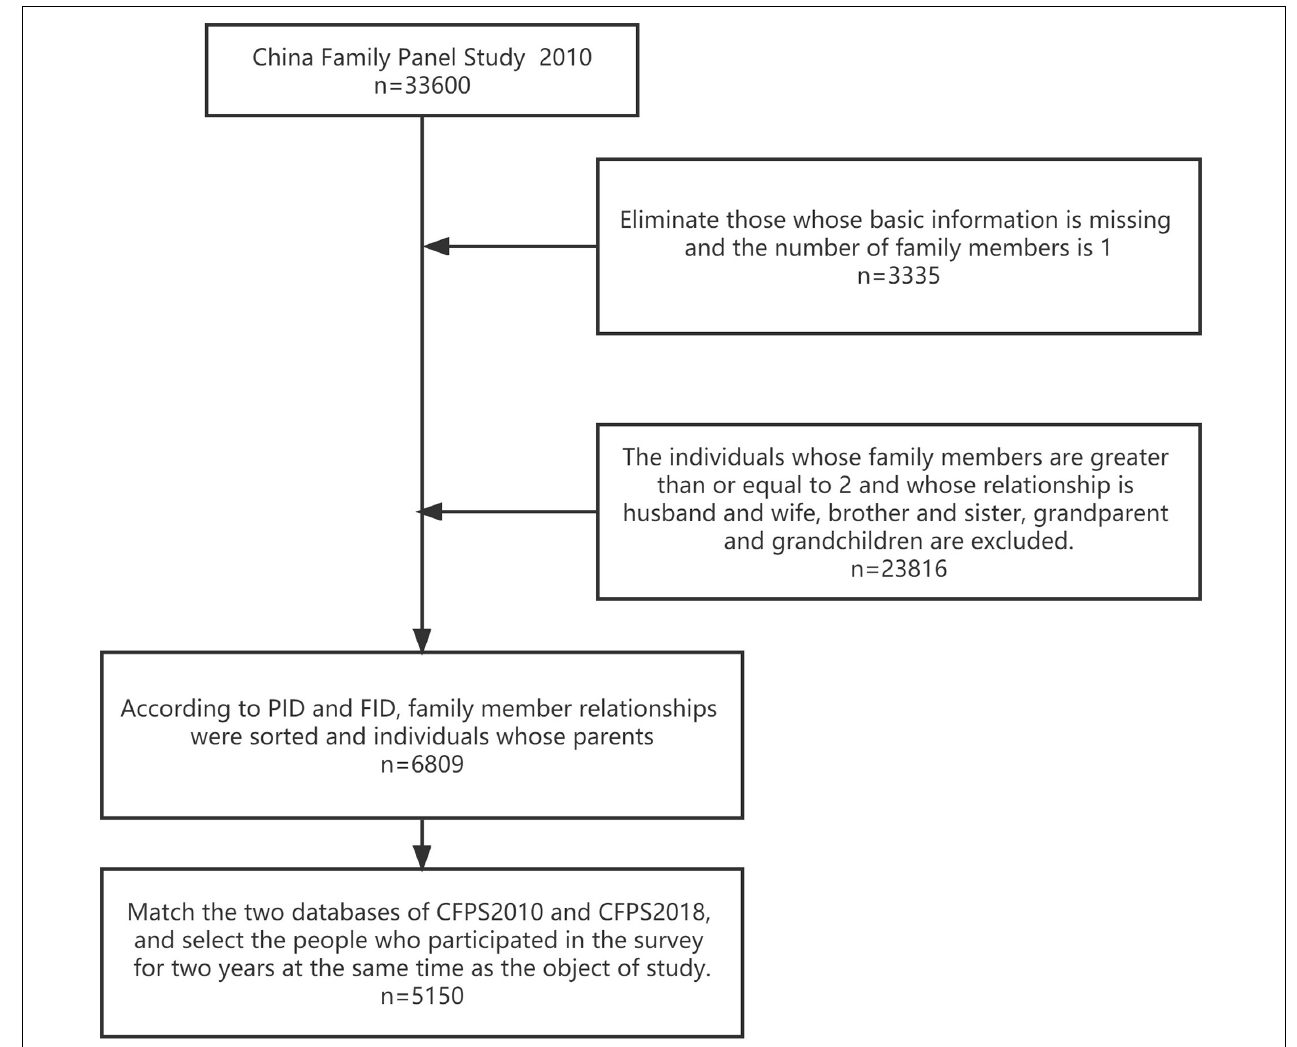
FIGURE 1 | Flow chart of patient inclusion. A total of 33,600 respondents participated in the survey in the 2010 CFPS database used in the study. Families that did not contain a parental-offspring relationship were excluded. After matching the rest of the 2010 CFPS data with the 2018 CFPS data, a total of 5,150 participants were